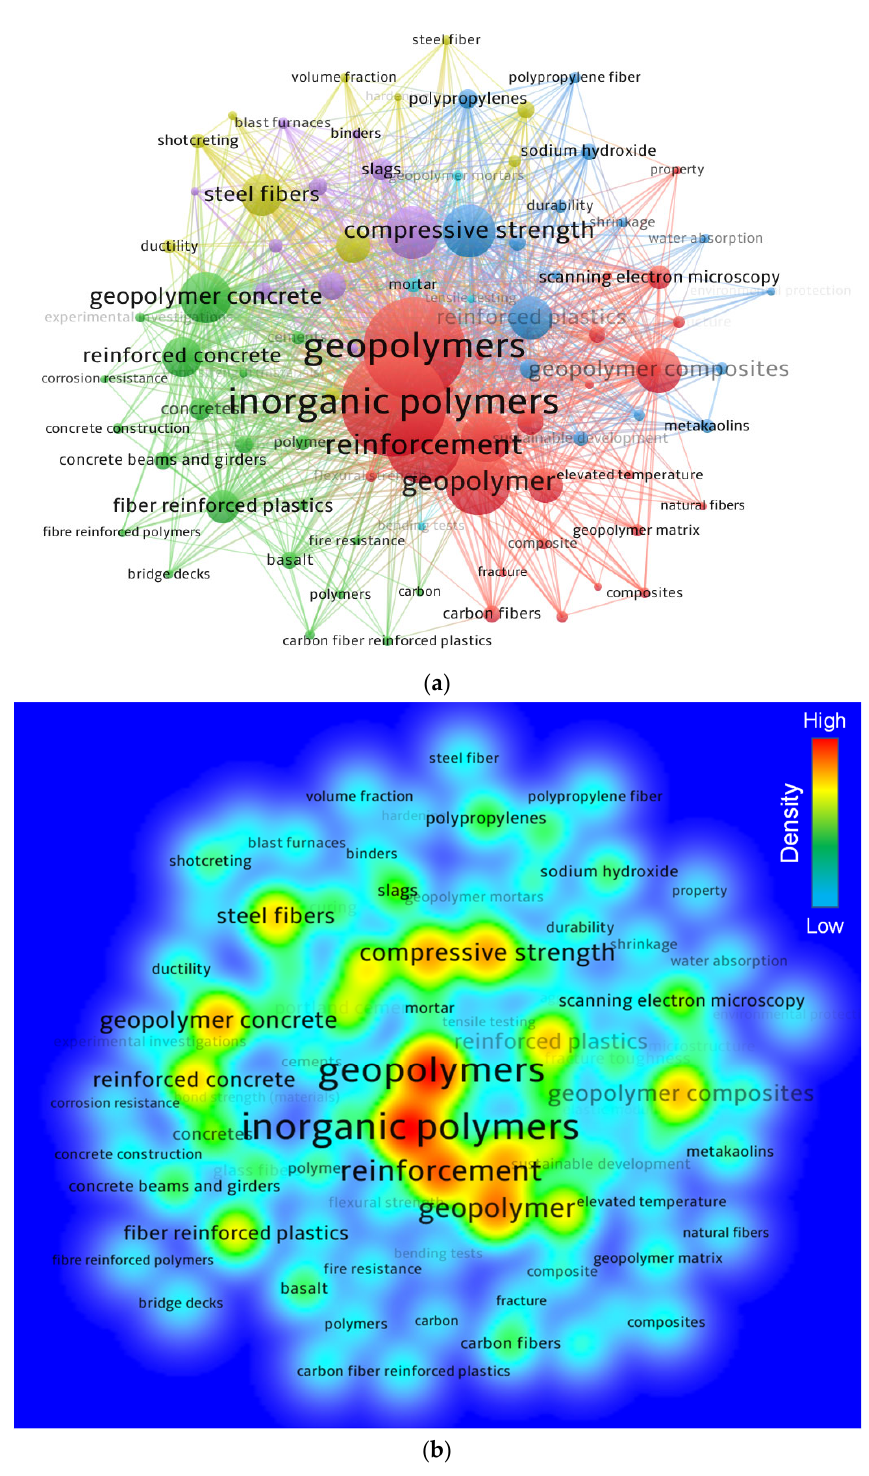
Figure 6. Systematic map of keywords in the research of FRGP: ( a ) visualization map; ( b ) density.